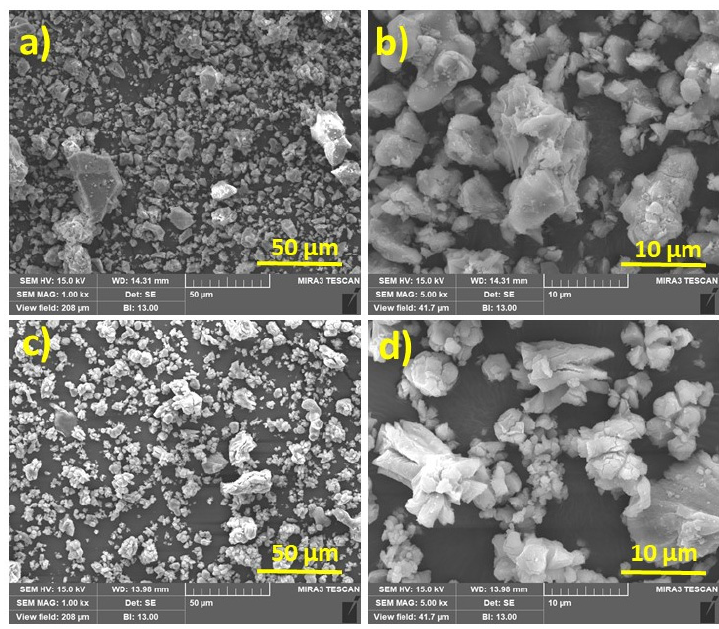
Figure 3 . FTIR spectra of SSP and SSA. Figure 3. FTIR spectra of SSP and SSA.